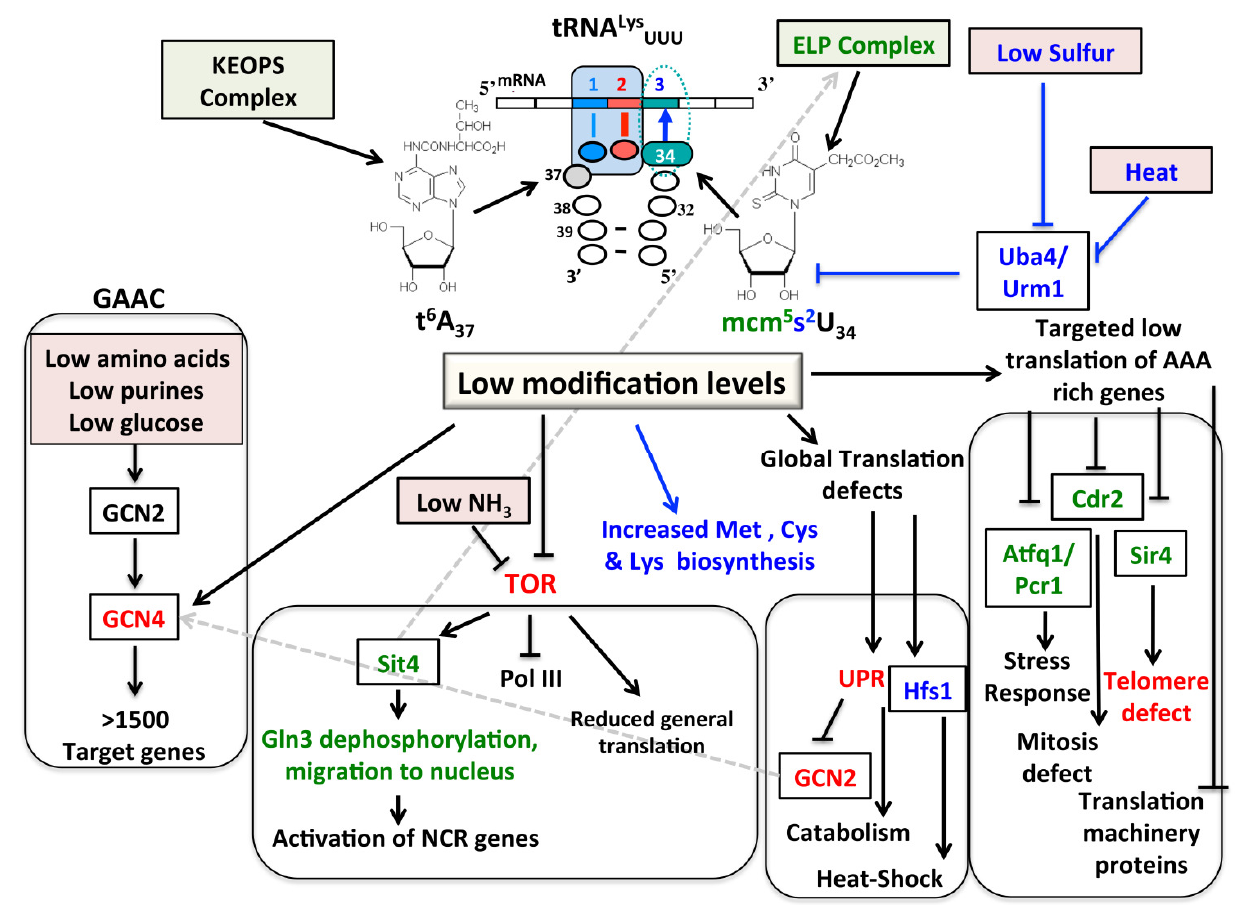
FIGURE 1: Possible cascade of events triggered when s 2 U, mcm 5 U or t 6 A levels are reduced in tRNA Lys UUU . Alteration in the levels of mcm 5 s 2 U occurring at position 34 of the tRNA (wobble position) and t 6 A occurring at position 37 (adjacent to the first base of the anti- codon) have global cellular affects. Reduction in either modification alters many regulatory cascades with the text color indicating the modi- fication responsible for the change (red indicates expression change seen in t 6 A and mcm 5 s 2 U mutants). Solid lines represent experimental data; dashed lines indicated potential points of